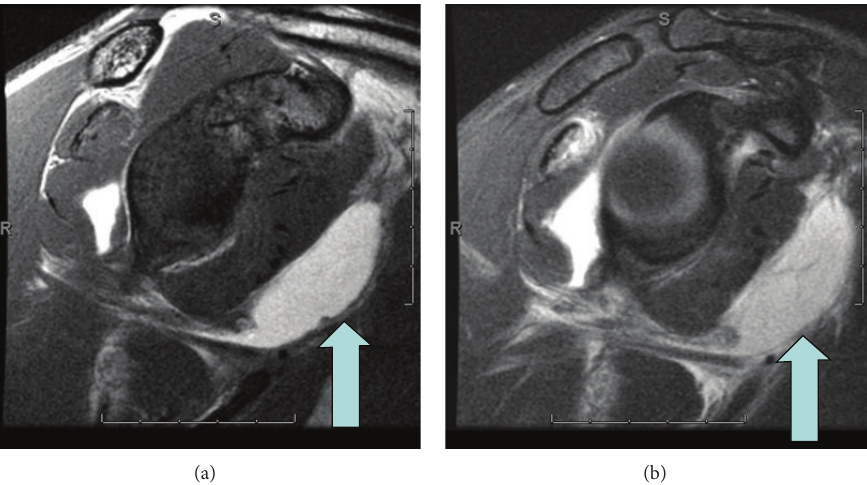
Figure5:Case 10 .ObliquesagittalT1andT2demonstratecontrast/fluidinthequadrilateralspaceandextendinganteriortothesubscapularis muscle (arrow).